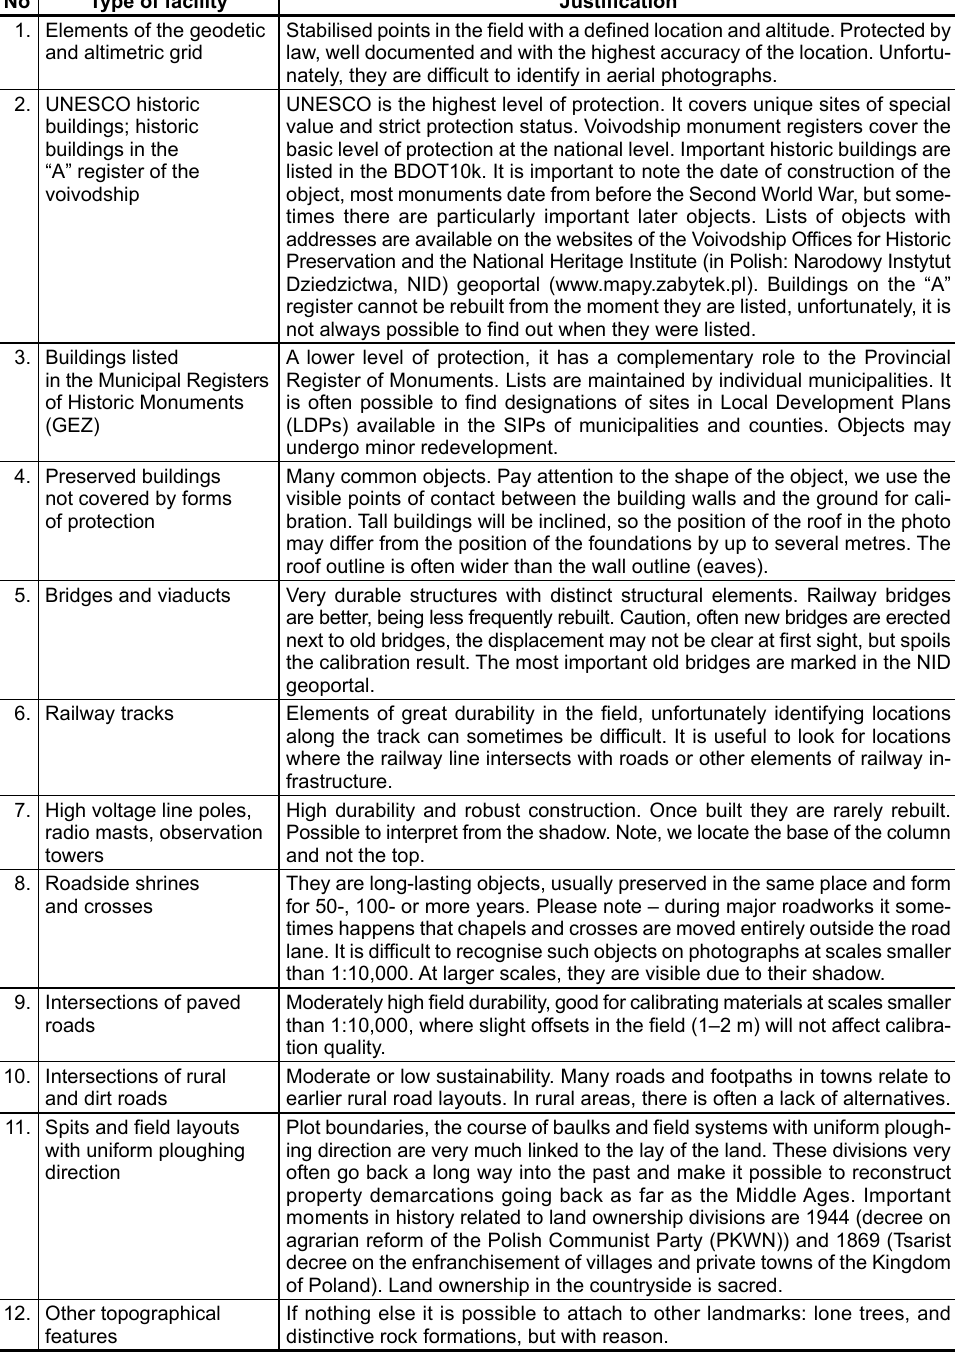
Table 2. Selection criteria for objects to be calibrated – order of selection of Ground Control Points (GCPs)